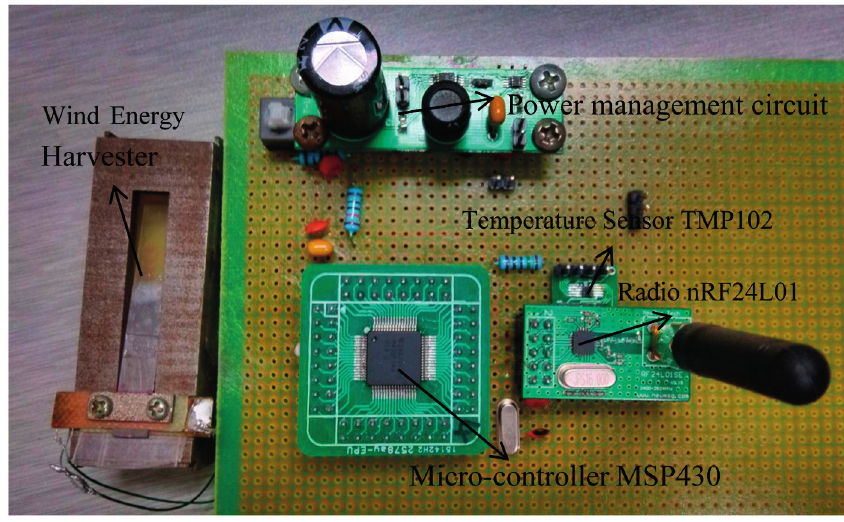
Figure 10. The photo of the self-powered wireless temperature sensor